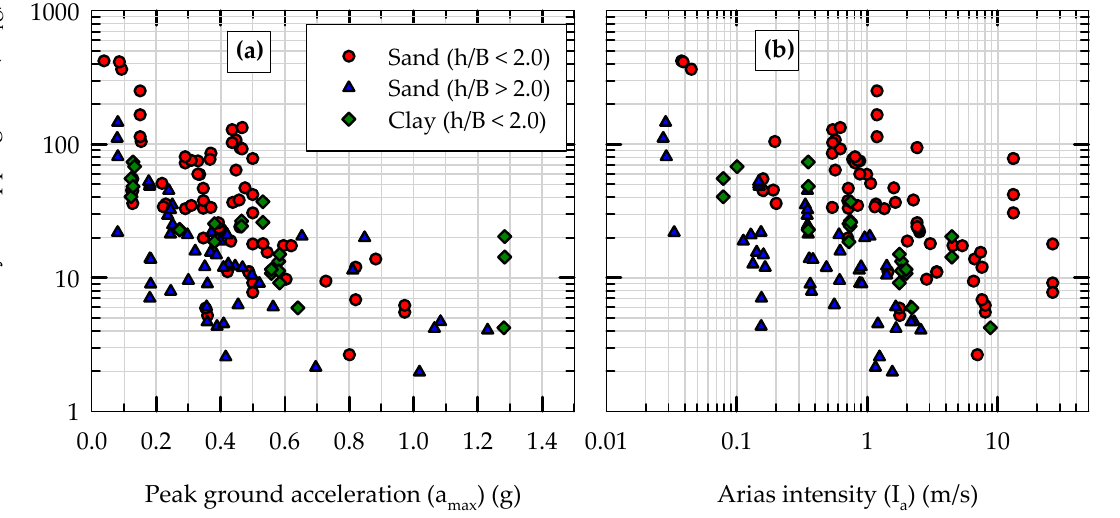
Figure 4. Variation of factor of safety for tipping over (FS TO = θ crit / θ peak ) with ( a ) peak ground acceleration and ( b ) Arias intensity of ground motion for rocking structure–foundation systems with different slenderness ratios (h/B).